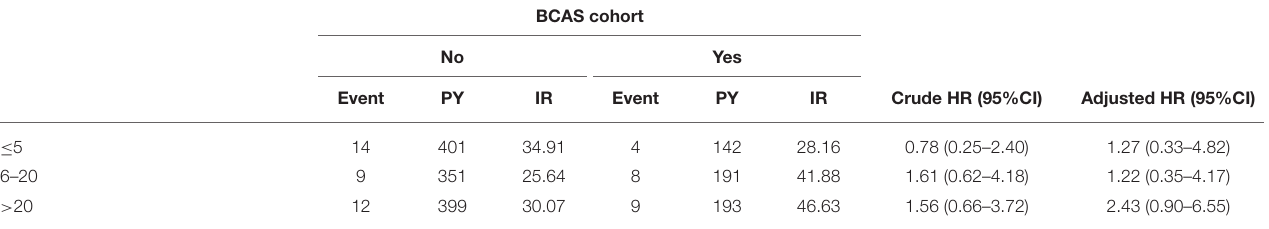
comparing with the non-BCAS cohort. However, the (current, recent) use and medium dosage of alprazolam were associated with a higher risk of HDS. Second, steroids (past ICSs, current OSs, any dose ICSs/OSs) were associated with a higher risk of HDS, even at a low dose, in the BCAS cohort than in the non- BCAS cohort. In addition, with patients not using OSs as the reference group, the results revealed that OSs use was associated with a lower risk of HDS. Third, the high dosage and current use of SABAs were associated with a higher risk of HDS. However, with patients without using SABAs as the reference group,